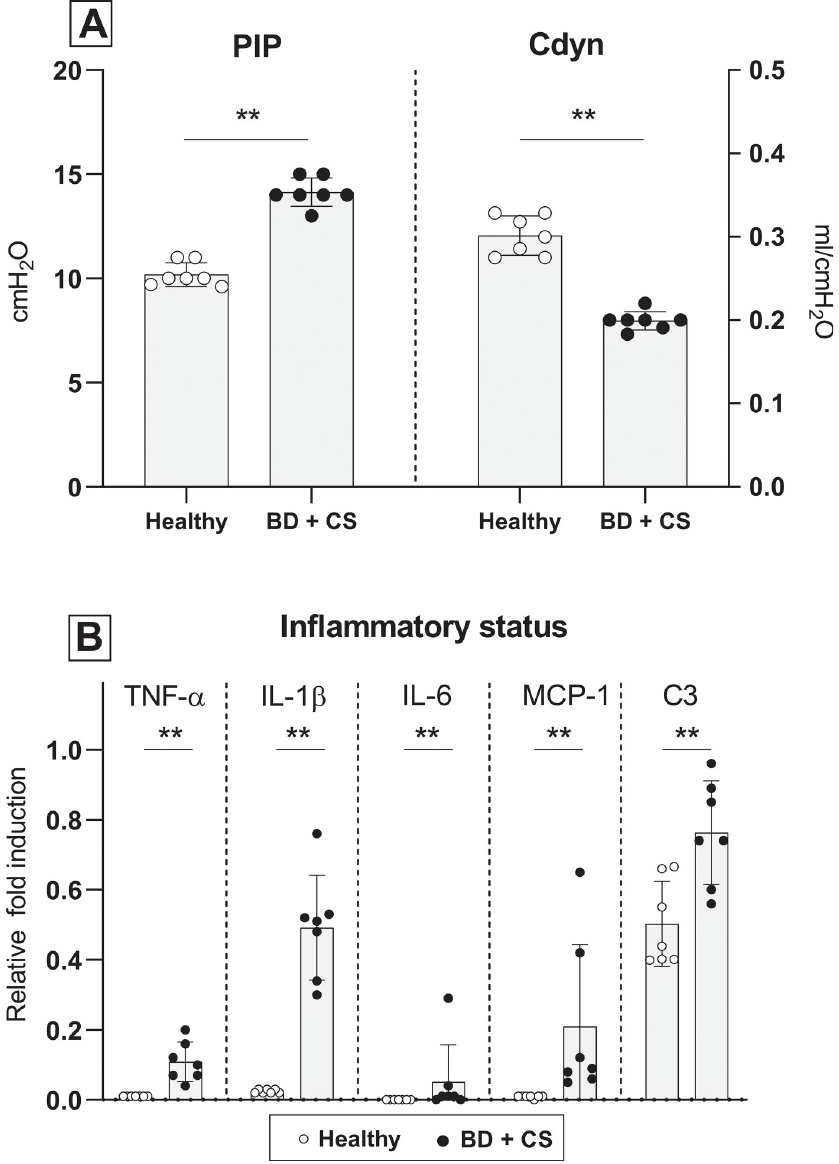
Fig 4. Ventilation parameters and inflammatory status after lung procurement. Lungs were procured from either healthy rats (experimental group 1) or rats subjected to 3 hours of brain death (BD, experimental group 2). (A) Pulmonary Inspiratory Pressure (PIP) required to maintain tidal volume at 7 ml/kg of bodyweight and dynamic compliance (C dyn ) of healthy donor lungs 1) versus donor lungs subjected to 3 hours of BD, at time of lung procurement. (B) Pro-inflammatory gene expressions of TNF- α , IL-1 β , IL-6, MCP-1 and C3 of healthy donor lungs versus donor lungs subjected to 3 hours of BD. �� p < 0.01 in healthy donor lungs versus lungs from brain-dead donors.